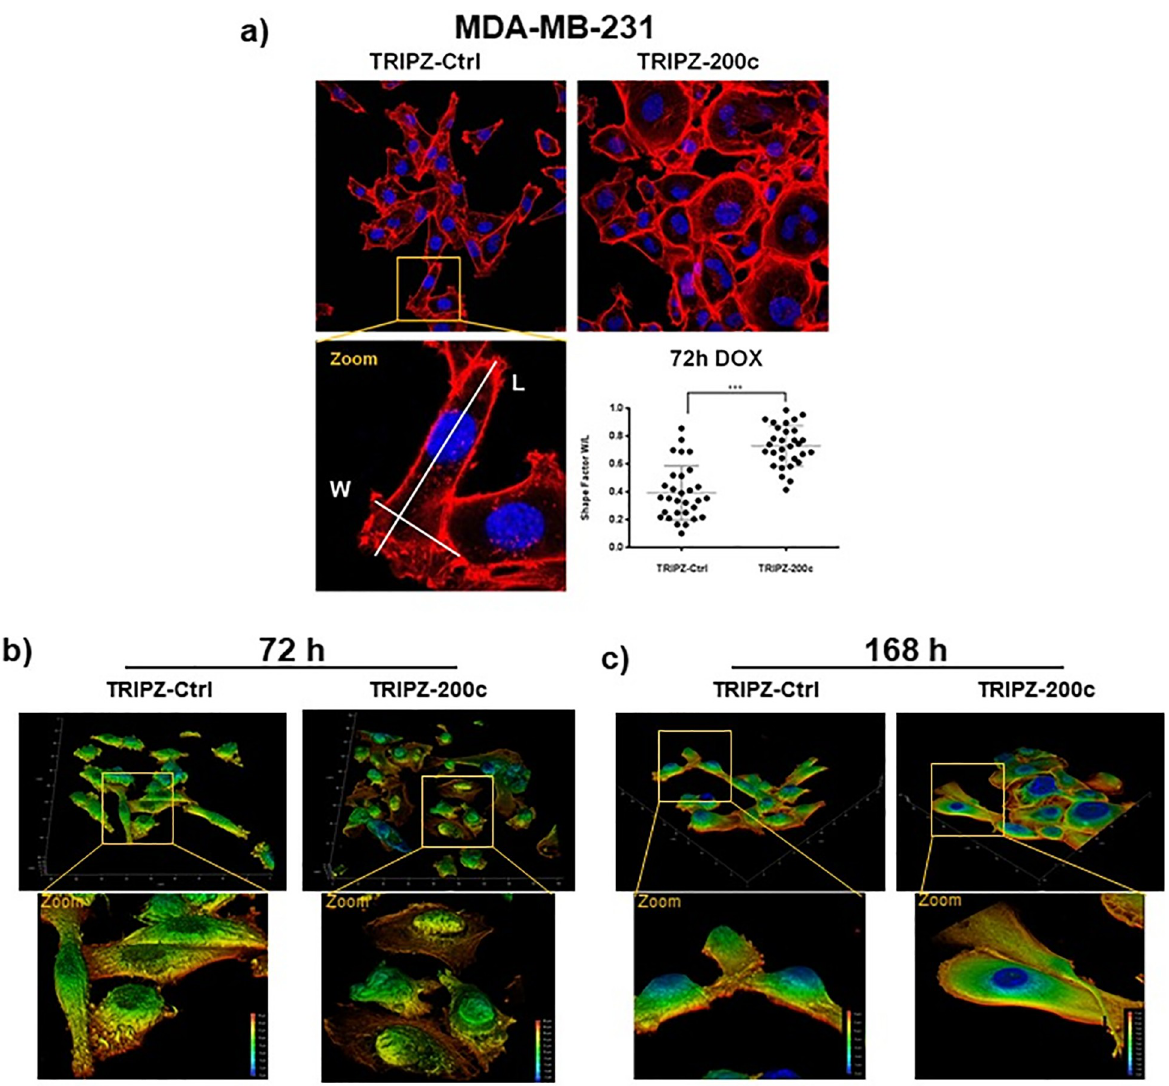
Fig 3. Overexpression of miR-200c induced fast morphological changes in MDA-MB-231 cells. (a) Fluorescence staining of the actin cytoskeleton by phalloidin (red) and nuclei (blue) in MDA-MB-231 decreased spindle-like phenotype after induction miR-200c, as shown by significant changes in the shape factors (N = 30; error bars are SD; ��� p > 0.001). (b, c) Renderings of z-stacked immunofluorescence images of MDA-MB-231 acquired by confocal imaging showed decreased mesenchymal shape in 3D after induction of miR-200c for (b) 72 h as well as (c) further increased effects after 168 h compared to included